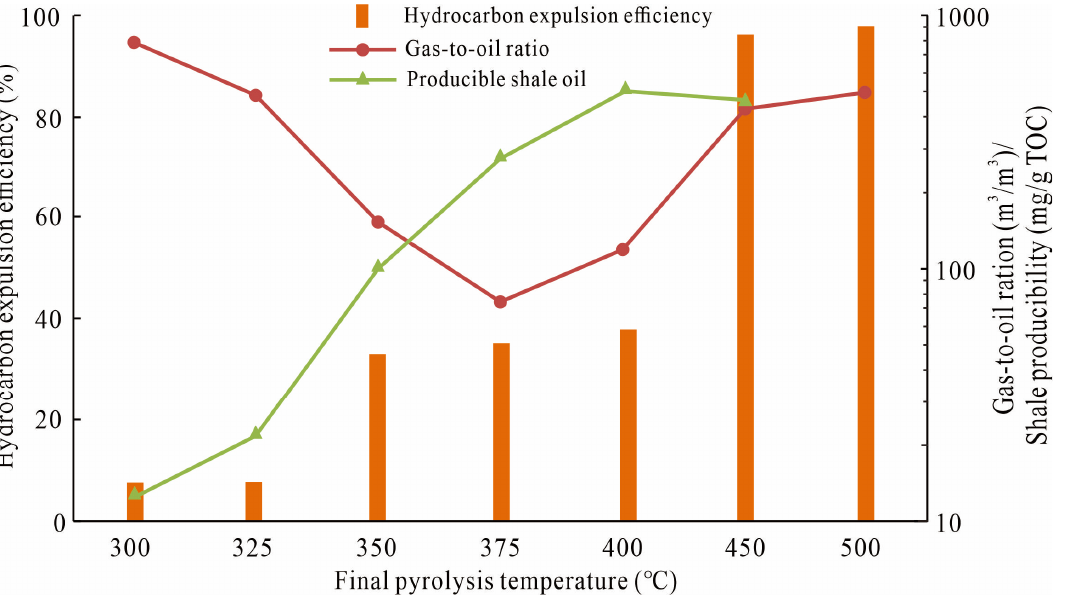
Figure 14. Gas–to–oil ratio, hydrocarbon expulsion efficiency, and producible shale oil as a function of thermal temperature.